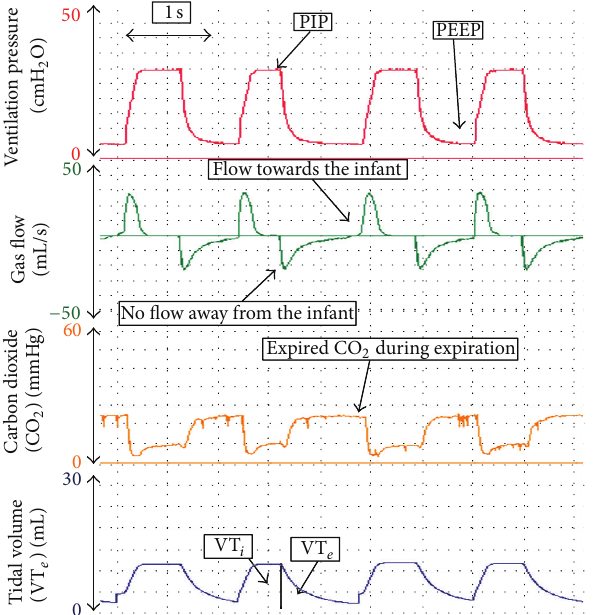
Figure 1: During positive pressure ventilation (PPV), the airway pressures rise to set PIP. At the end of inspiration, PIP decreases to baseline (PEEP). The area underneath the gas flow waves during inflation and expiration is similar, which is reflected in the 𝑉 𝑇 wave returning to the baseline after expiration. No leak is displayed.